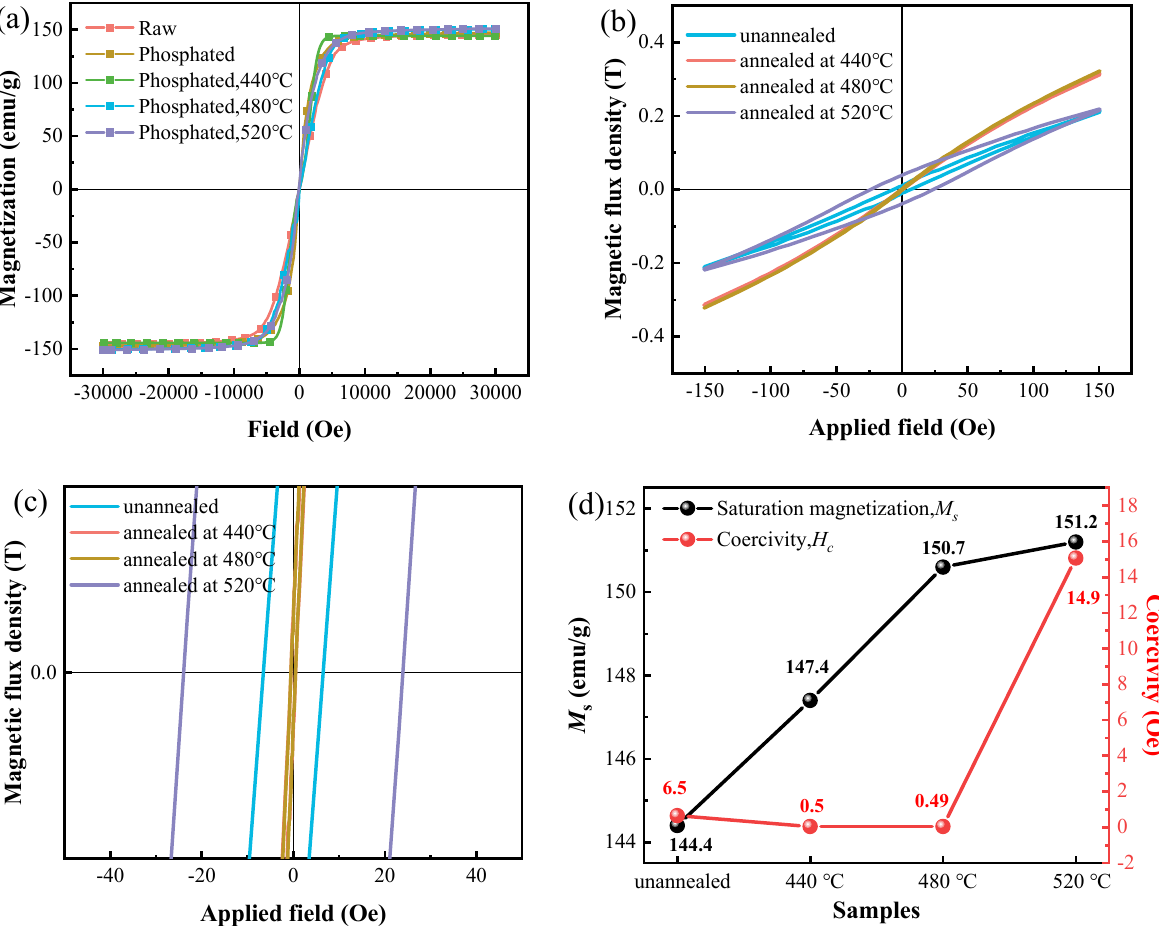
Figure 4. ( a ) M-H curves of the raw powders, coated powders and powders annealed at different temperatures; ( b , c ) show the DC magnetic hysteresis loop and the partial loops of the AMPCs in field H = ± 150 Oe; ( d ) saturation magnetization M s and coercivity H c of AMPCs before and after being annealed at different temperatures.